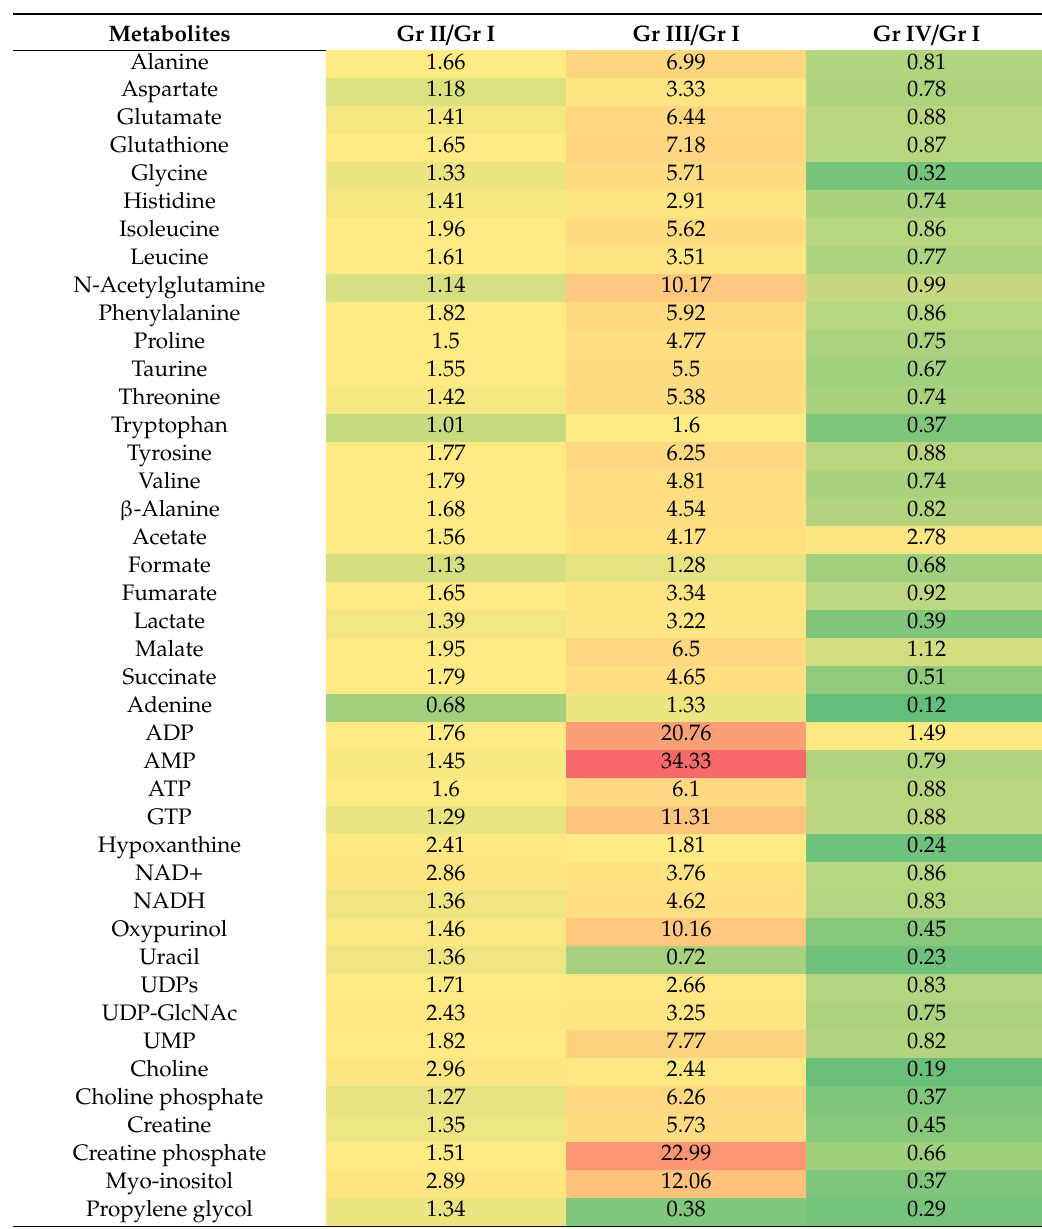
Table 1. The identified metabolites and the calculated fold change ( × ) during UBC progression, taking grade I (RT4) as the cell group of reference. A three-color gradient is applied, depending on the fold change ( × ) value. Red denotes the highest value(s). Gr: (malignancy)